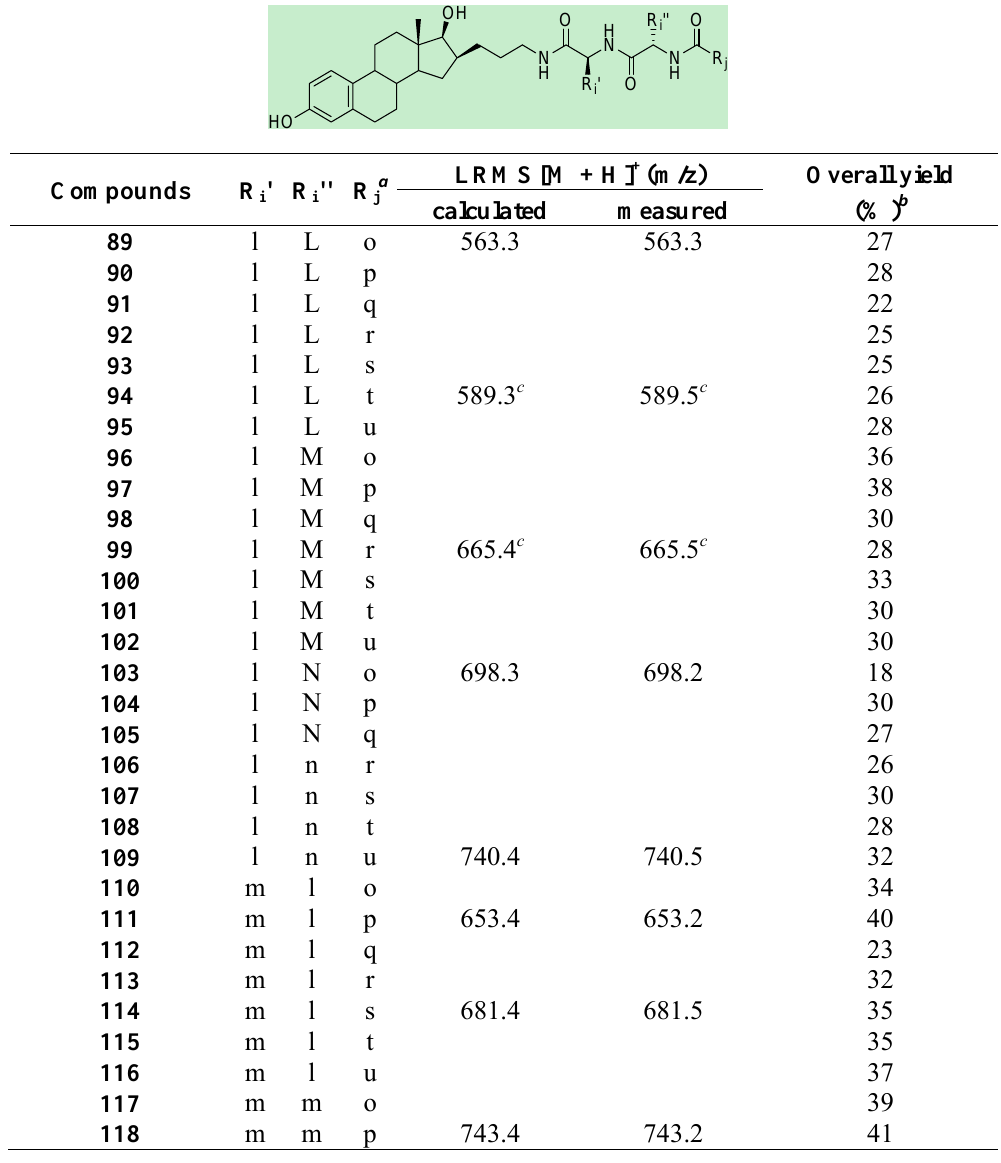
derivatives 89–123 2